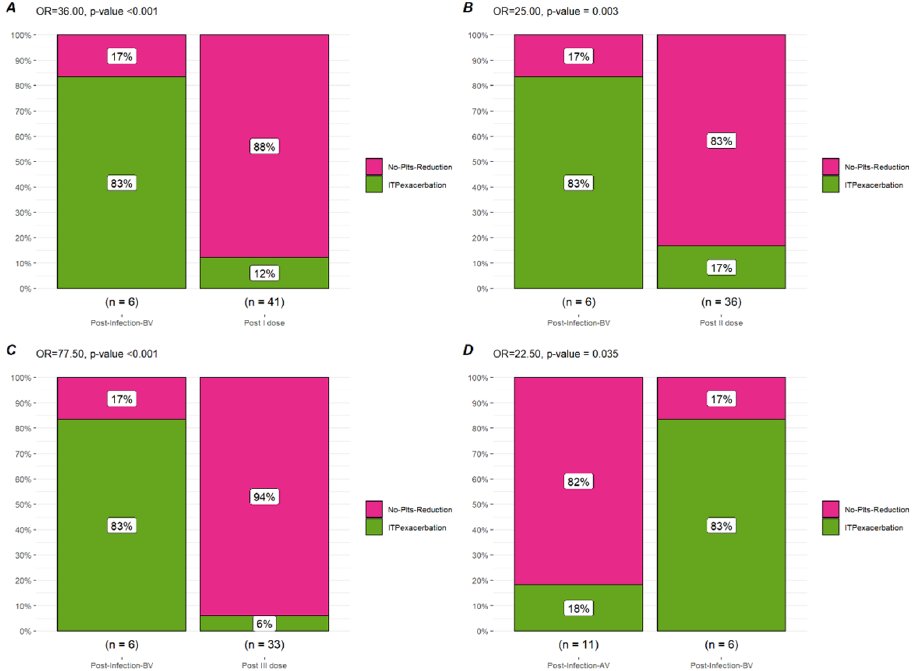
Figure 2. Bar plot of ITP exacerbation . Comaprison in terms of ITP exacerbation between infection before vaccination (Post-Infection-BV), Post first vaccine dose (Post I dose) ( A ), second dose (Post II dose) ( B ), and third dose (Post III dose) ( C ) and post-infection after vaccination (Post-Infection-AV) ( D ).